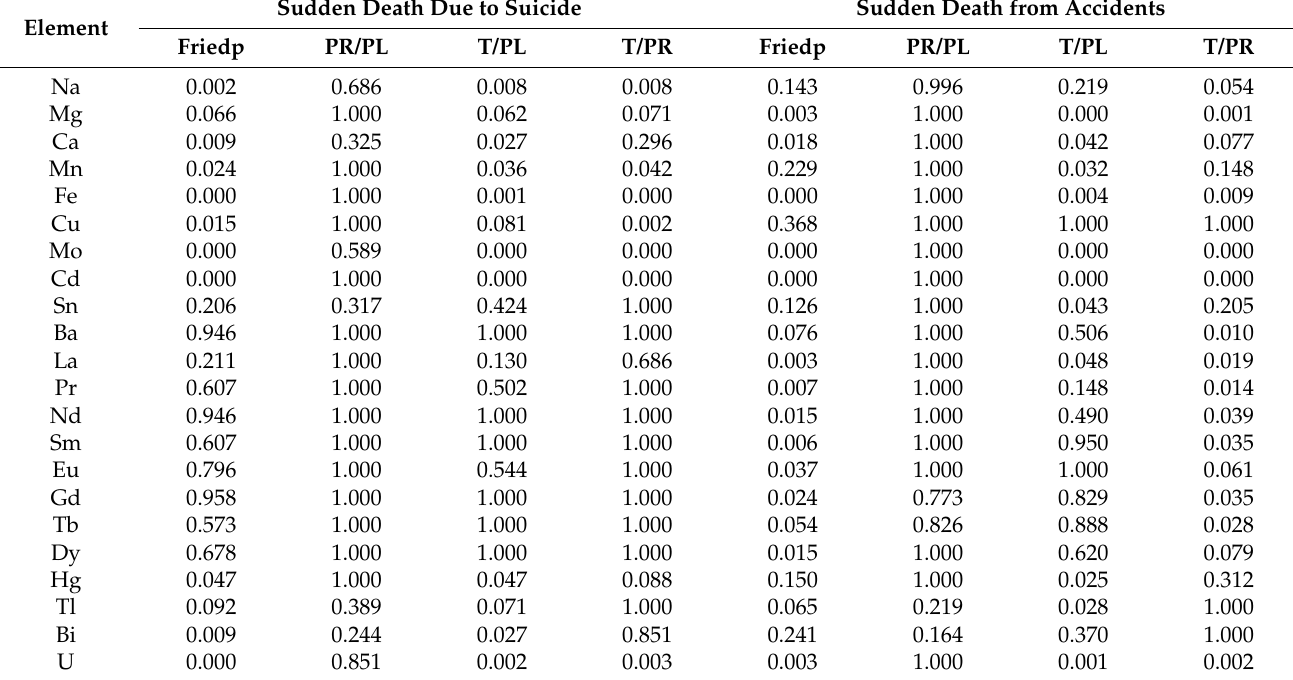
Table 2. Results of statistical differences ( p -values) in elemental composition between meninges